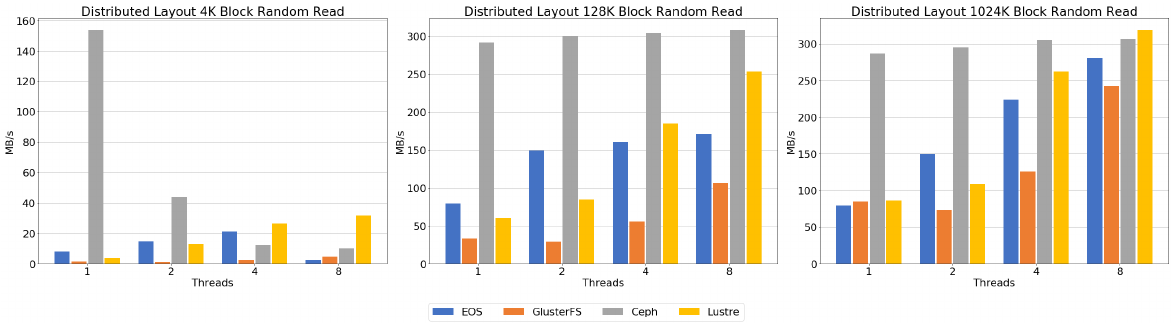
Figure 12. Distributed layout—random read result.